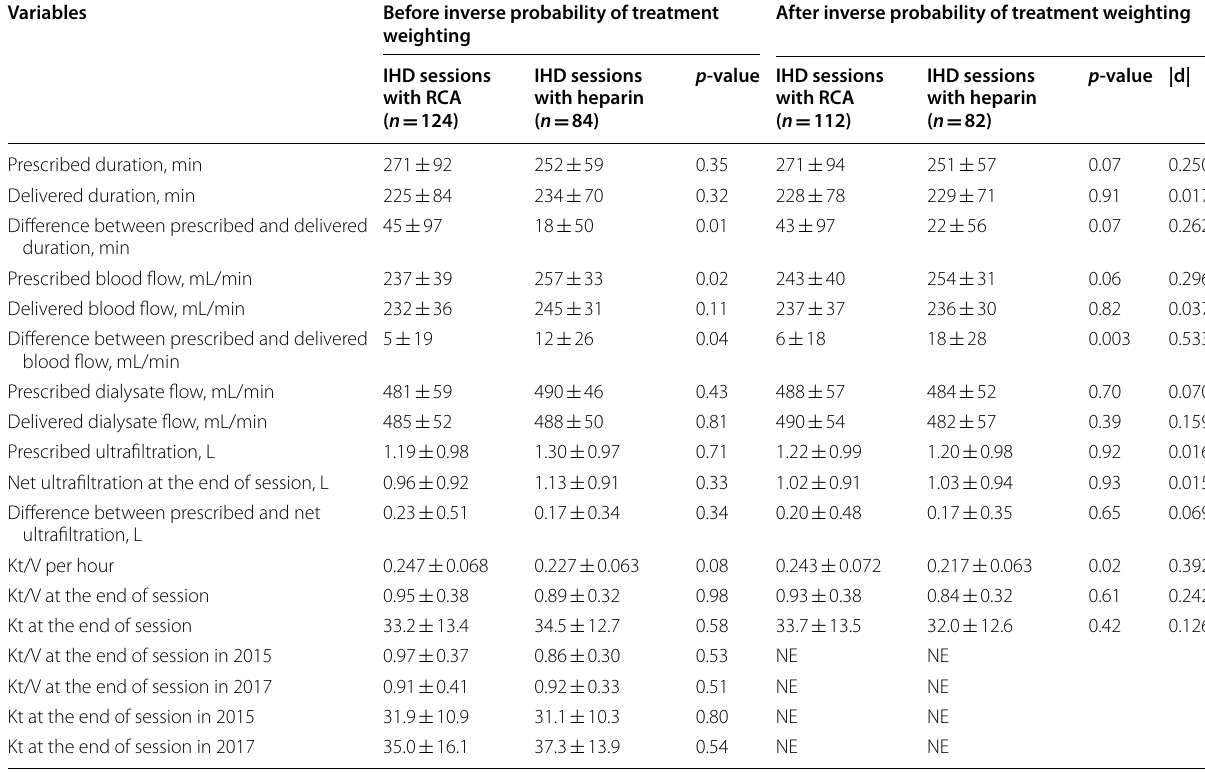
NE not evaluated (Inverse probability of treatment weighting was not applied to the subgroup analyses in 2015 and 2017), RCA regional citrate anticoagulation, IHD intermittent hemodialysis